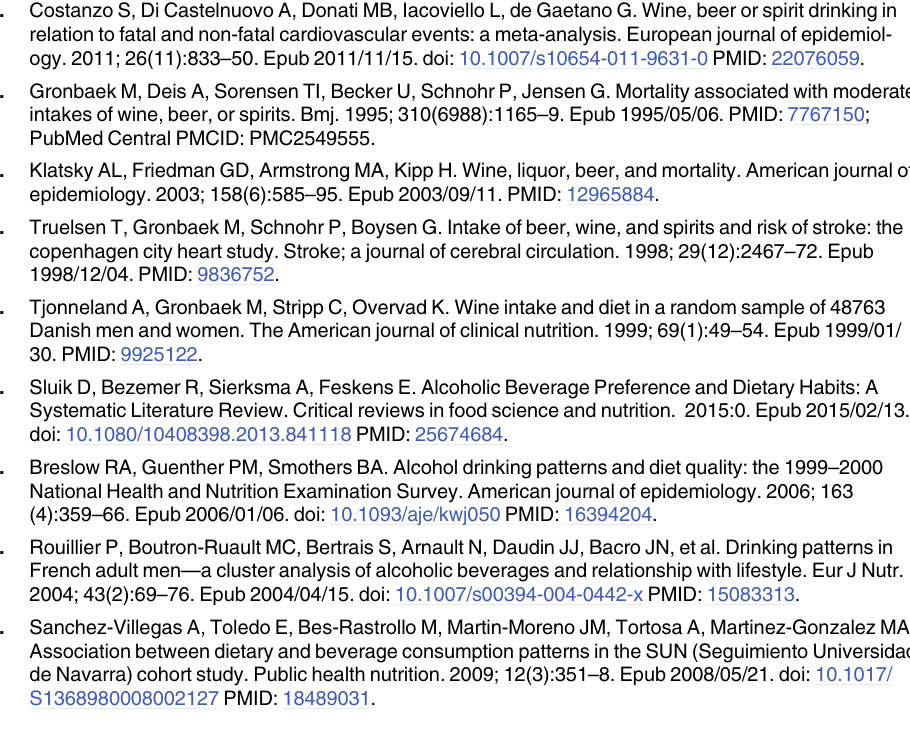
S1 Table. Adjusted food group and nutrient intakes (weighted mean and SE) across catego- ries of alcoholic beverage preference in those excluding prevalent diseases, and stratified by gender, BMI-category, and alcohol consumption